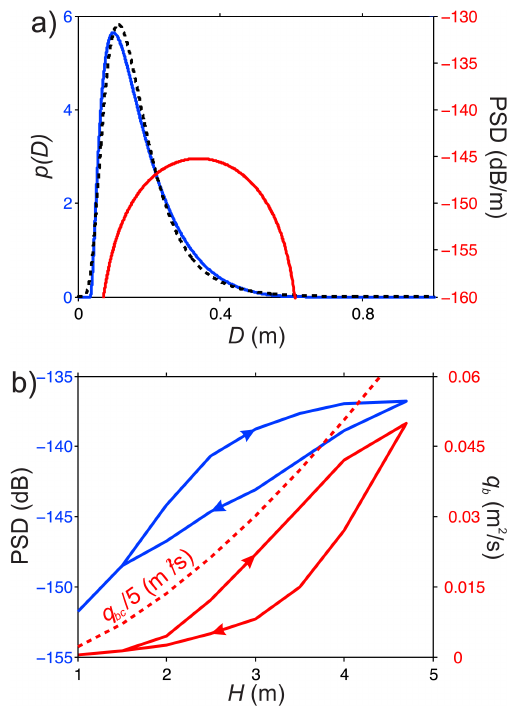
Figure 6. Sensitivity of power spectral density (PSD) to grain size, and inversion of PSD data for Q b from Tsai et al. (2012). (a) Grain size probability distribution (blue) and resulting PSD (red). (b) Pre- diction of Q b (red) from fitting PSD data of Burtin et al. (2008) for station H0460 (300m from the river) at [3–15]Hz (blue).